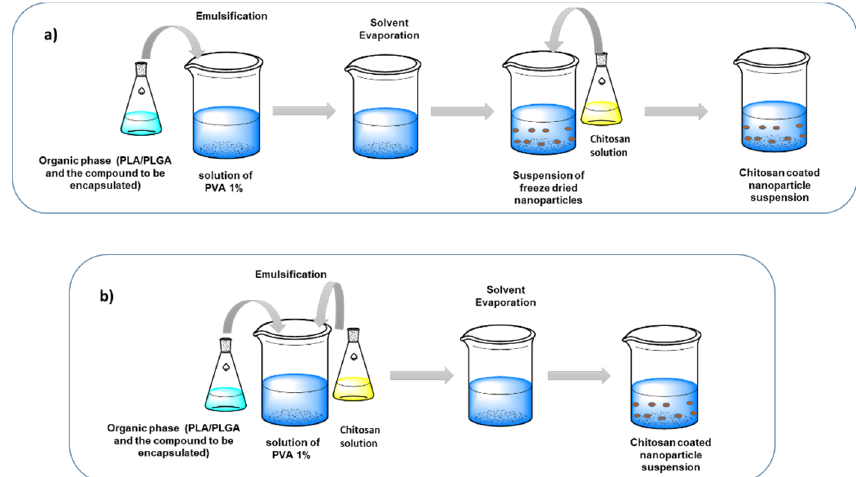
Figure 7. Schematic illustration of different strategies used for the formation of chitosan-coated poly (lactic acid) (PLA)/poly (lactic- co -glycolic acid) (PLGA) nanoparticles; formation of chitosan-coated nanoparticles (CCNs)( a ) using pre-formed negatively charged nanoparticles and ( b ) during the formation of the nanoparticles.